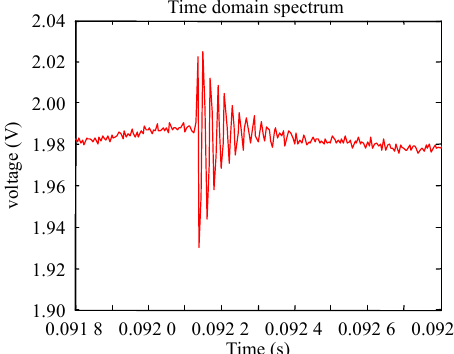
Fig. 8 Typical micro plasma shock wave acoustic emission signal by femtosecond laser ablation of aluminium iron copper alloy